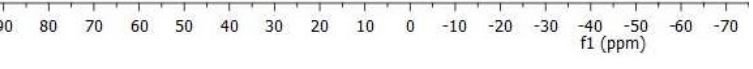
Figure 6. 29 Si-NMR spectrum of the product.